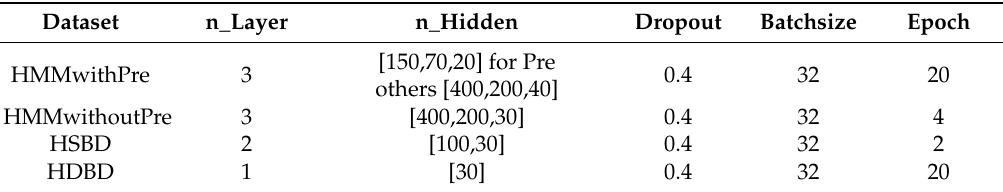
Table 7. The network structure for